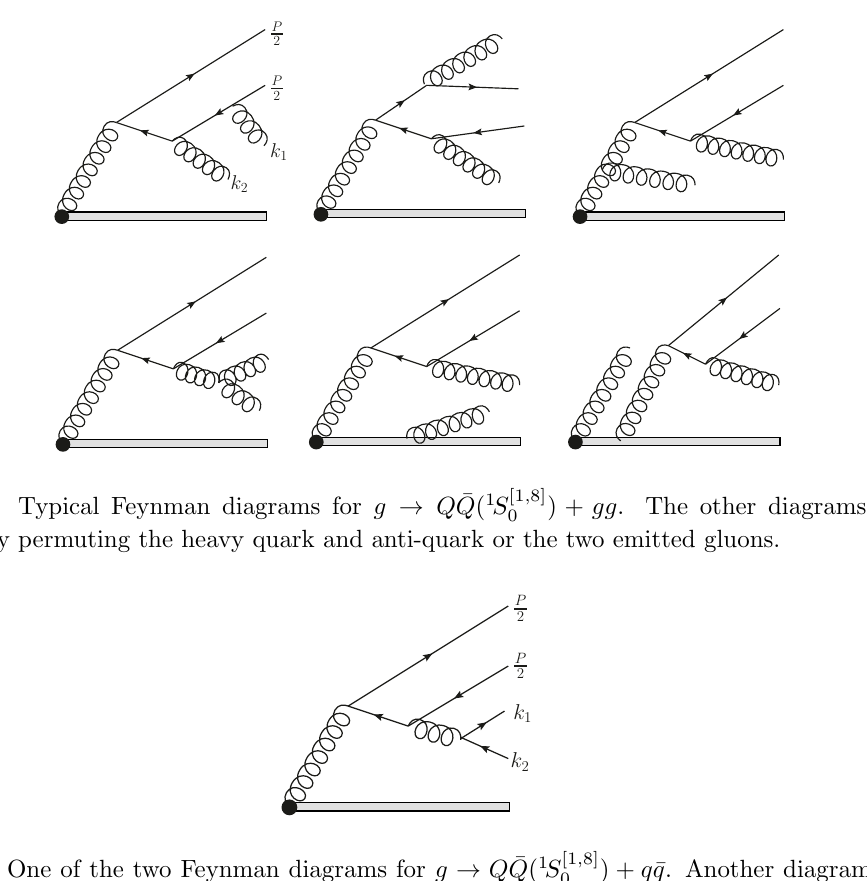
) + q (cid:22) q . Another diagram can be 0